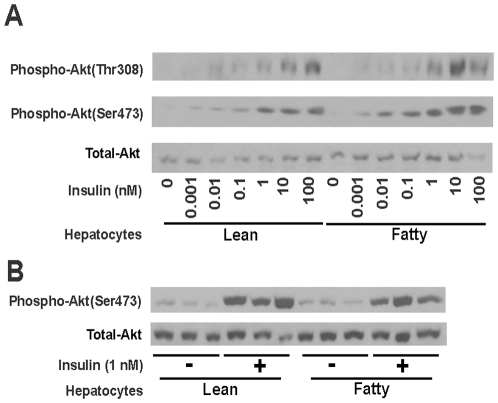
Immunoblot analysis of phospho-Akt and total Akt levels in primary hepatocyes treated with increasing concentrations (A) or 1 nM (B) of insulin.After overnight pretreatment, primary hepatocytes from ad libitum ZL and ZF rats were incubated in medium A containing indicated concentrations of insulin for 10 minutes. After which, hepatocytes were washed once with 3 ml PBS and lysed as described in Materials and Methods. Total protein (30 µg/lane) was separated on 8% SDS/PAGE gels, detected by specific primary antibodies as indicated, and visualized by chemiluminescence. A. The levels of phoshpo-Akt(Thr308), phosphor-Akt(Ser473), and total Akt in ad libitum lean and fatty hepatocytes treated with increasing concentration of insulin (0 to 100 nM). Graph was the representative of three independent experiments with similar results using hepatocytes isolated from three different ad libitum ZL or ZF rats in different days. B. The levels of phospho-Akt(Ser473) and total Akt in ad libitum lean and fatty hepatocytes treated without or with 1 nM insulin. Graph represented three independent isolations of hepatocytes from different ad libitum ZL or ZF rats in different days, which were run side by side.